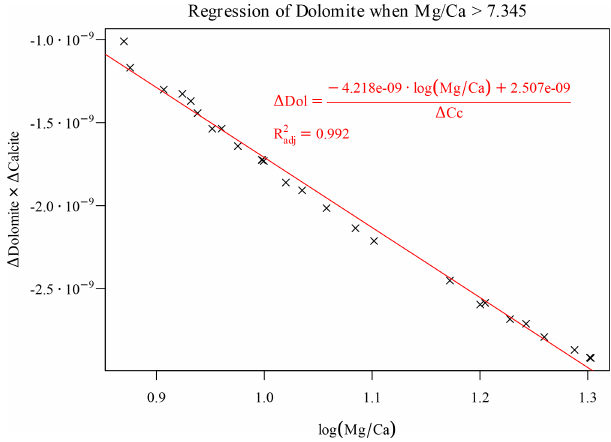
Figure 9. Regression of (cid:49) dolomite in the right-hand region of Fig. 8b.